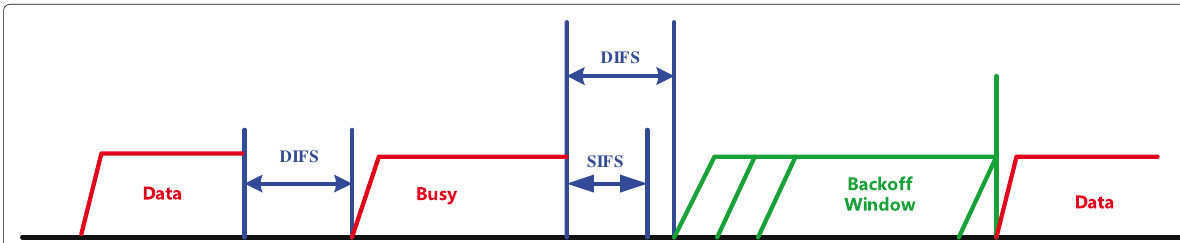
Fig. 9 Transmission procedure of a normal